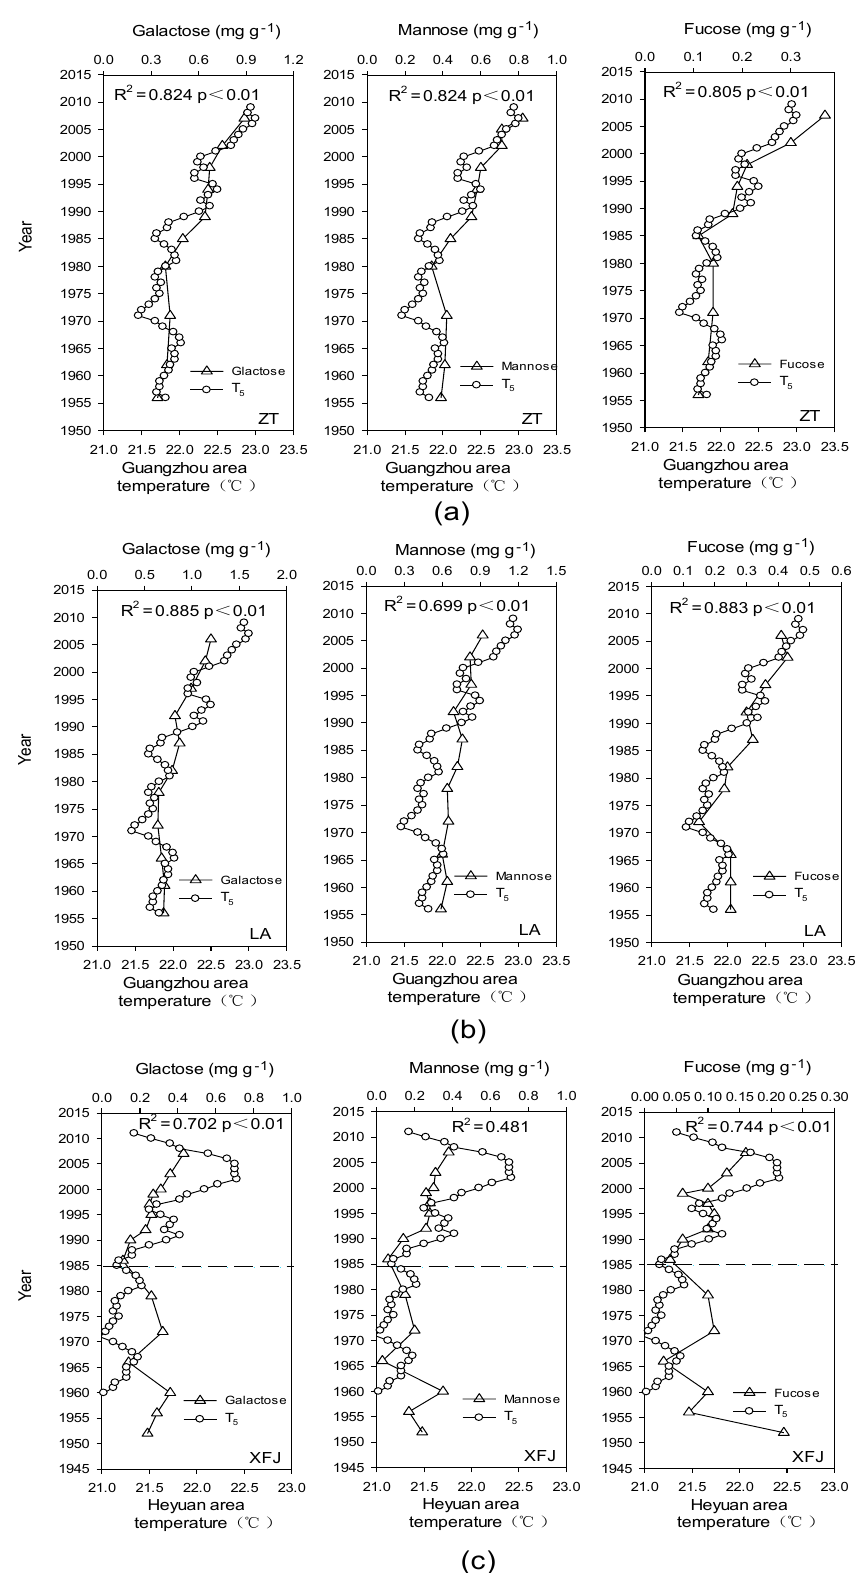
Figure 5. Temporal profiles of 5-year moving temperature ( T 5 ), hydrogen index (HI) and monosaccharides in sediment cores from the three